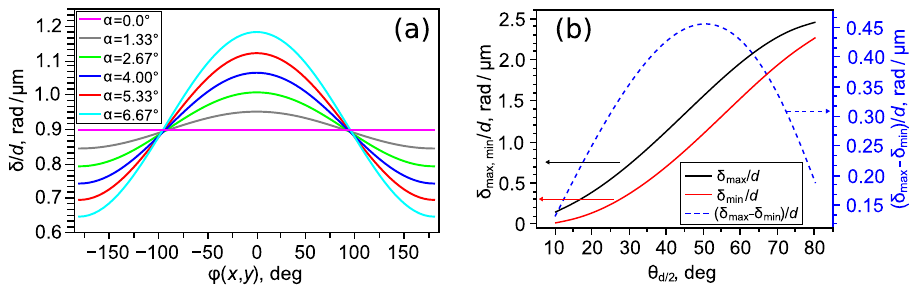
Figure 2. Dependencies of δ/ d ratio on the angle ϕ( x , y ) calculated for several light incidence α angles and the tilt angle θ d / 2 = 40 ◦ ( a ), dependencies of δ max / d , δ min / d and (δ max − δ max )/ d on the tilt angle θ d / 2 obtained for the light incidence angle α = 5.33 ◦ ( b ). The calculations have been performed at (cid:31) = 546 nm and the refractive indices of